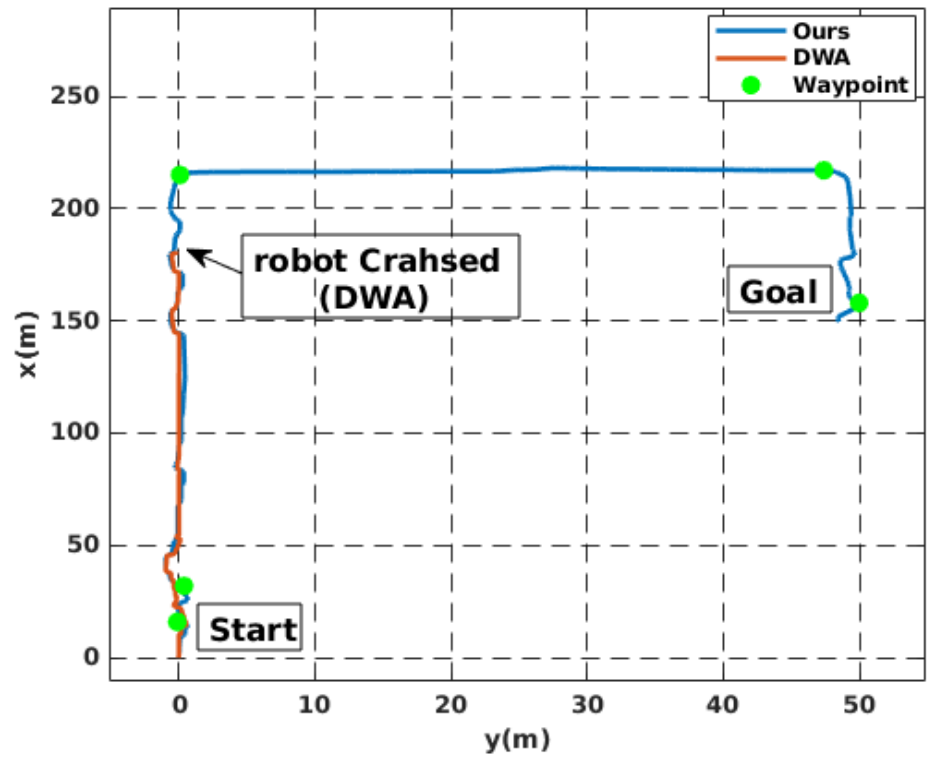
Figure 11. The path followed by the robot while avoiding obstacles in a simulated